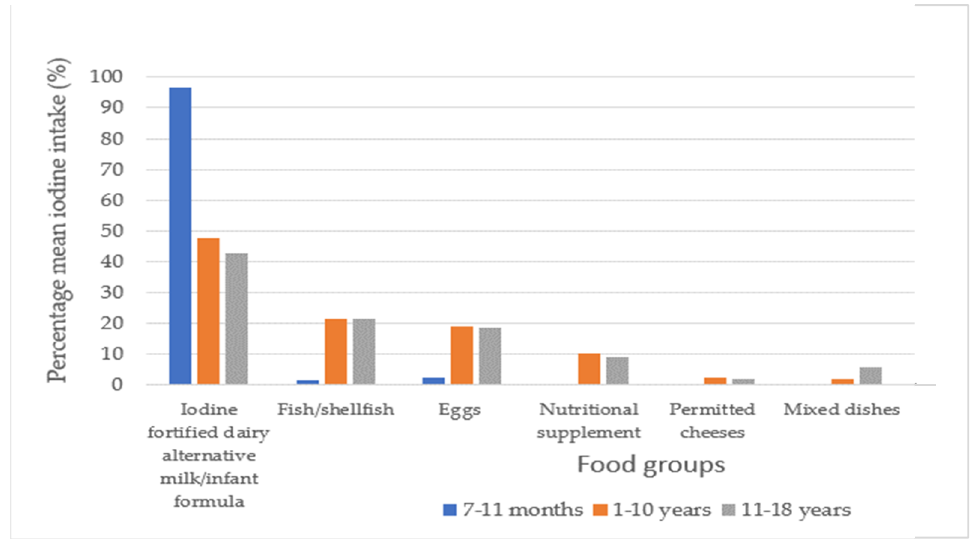
Figure 3. Dietary sources of iodine for infants and children with classical galactosaemia . A positive relationship between iodine intake from iodine-fortified dairy alternative milk (µg/day) and estimated iodine intakes (µg/day) was seen (R 2 = 0.61). The same analysis examining the relationships between iodine intake from fish/shellfish and eggs (µg/day) and estimated iodine intakes (µg/day) demonstrated a weak association.